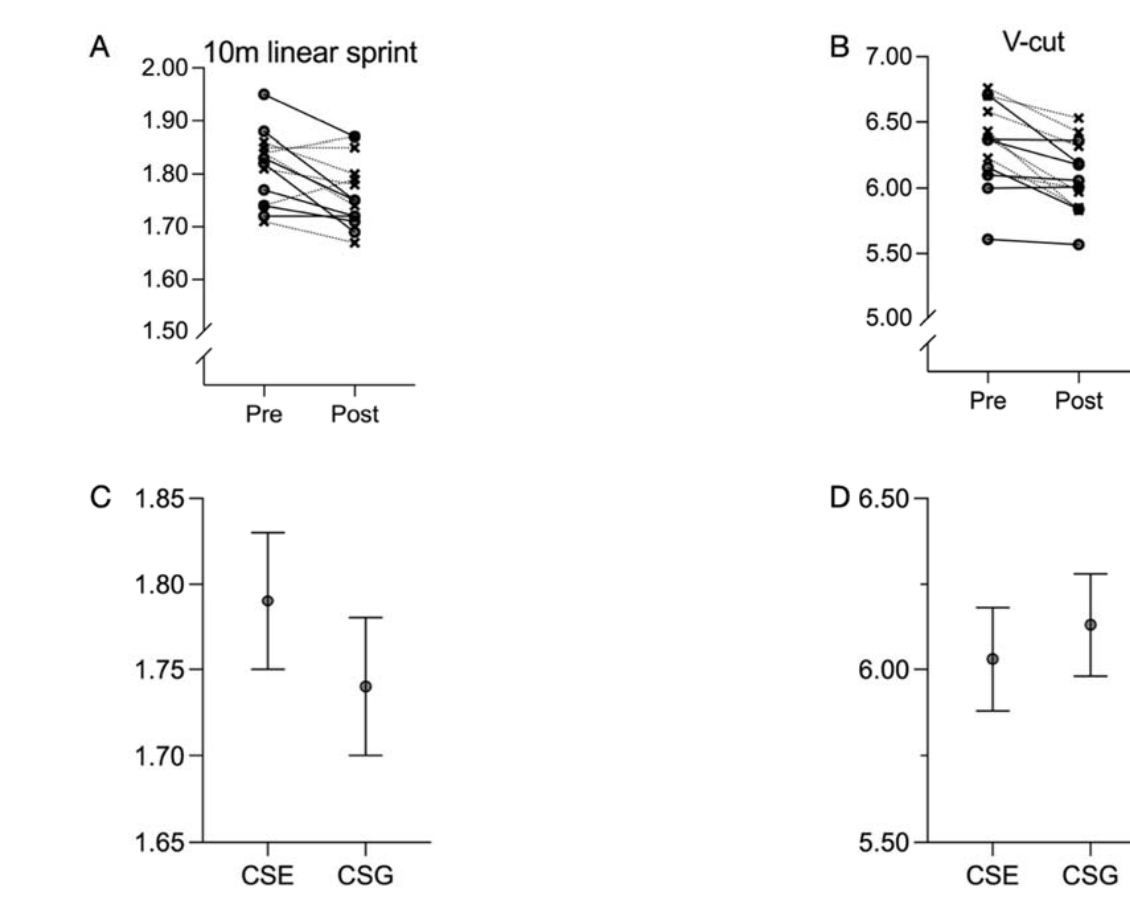
Figure 2. Performance scores changes for ( A ) 10-m linear sprint and ( B ) V-cut tests following both interventions. SCS group with dashed lines and cross symbols. GCS represented with solid lines a circle symbols. Comparison of adjusted mean values of both groups for ( C ) 10-m linear sprint and ( D ) V-cut tests following both interventions. SCS: specific CORE stability intervention group; GCS: general CORE stability intervention group. Table 13. Raw means and effect sizes for performance tests for the entire sample ( n = 14) and each group SCS ( n = 7), and GCS ( n = 7).